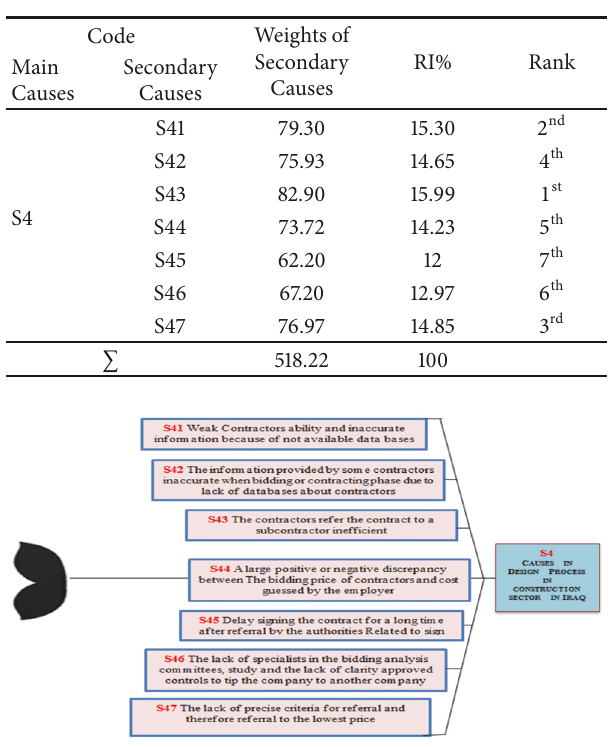
Table 7: Main causes weights, relative importance, and rank for project contract management process group.